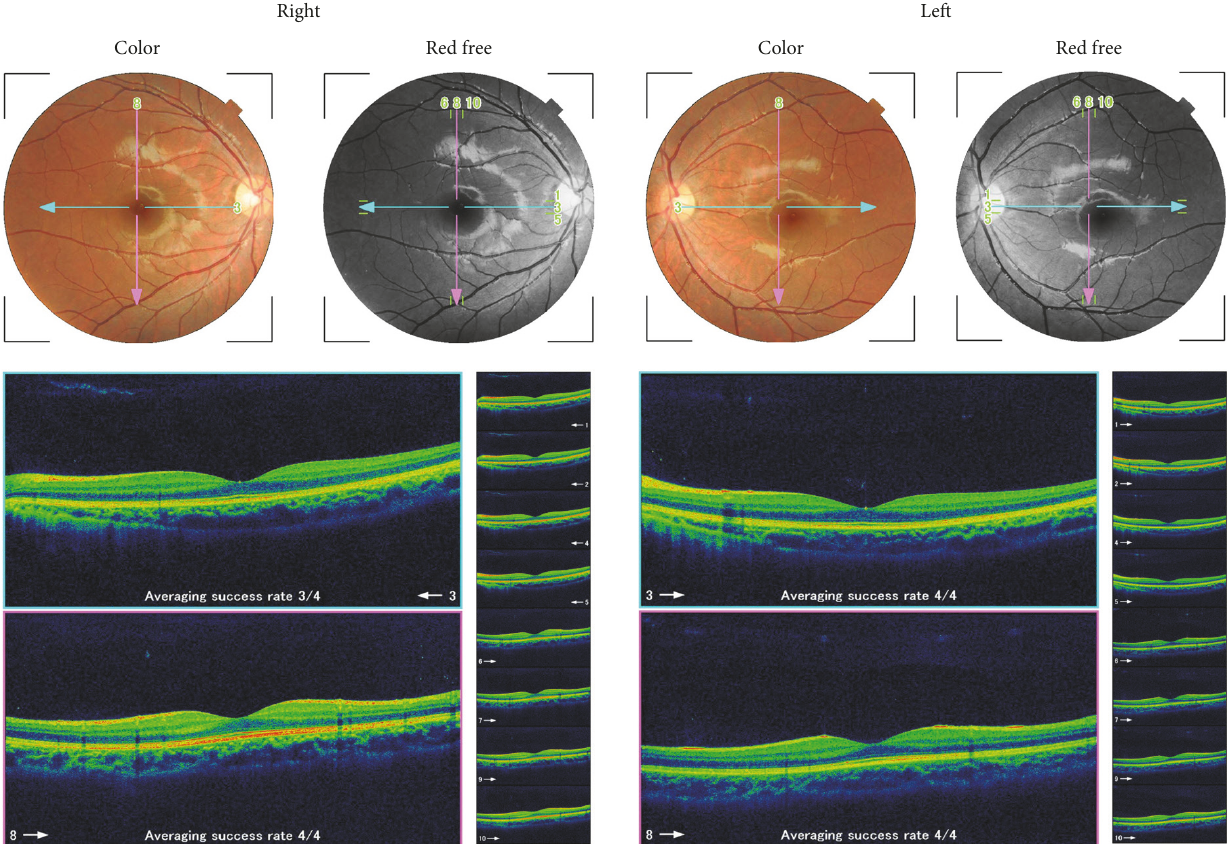
Figure 2: Fundus photographs and optical coherence tomographic image of both